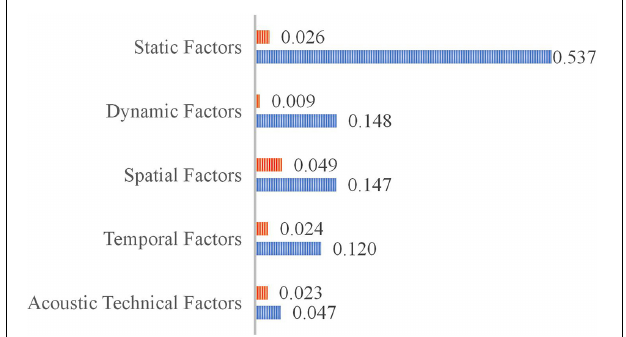
FIGURE 4 | Comparison of the total score (blue stripe) and the average score (red stripe) of different categories of